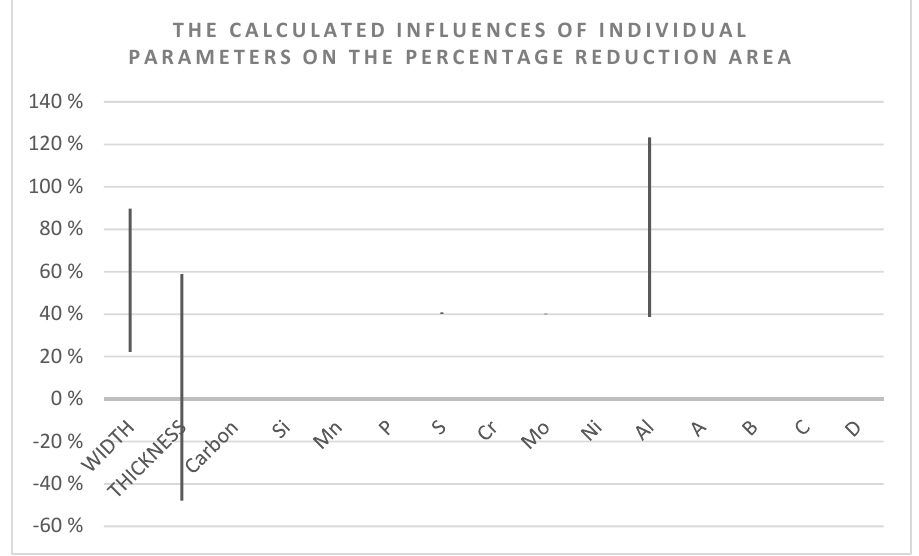
Figure 10. The calculated influences of individual parameters on the percentage reduction area while separately changing individual parameter within the individual parameter range.